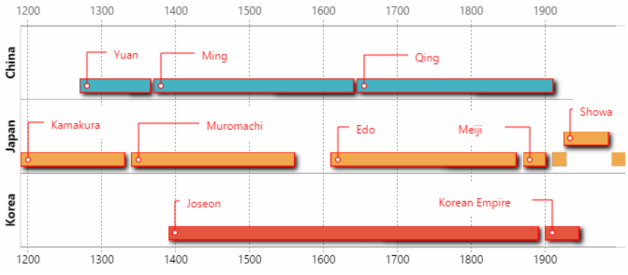
Figure 2. Some Empires of China, Japan, and Korea (https://timelinestoryteller.com/#examples).